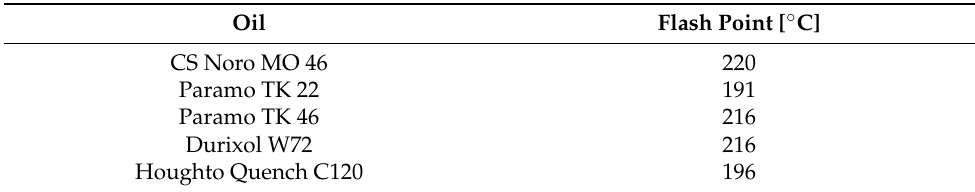
Table 6. Flash points for a quenching oil, hydraulic oil, engine oil and a synthetic